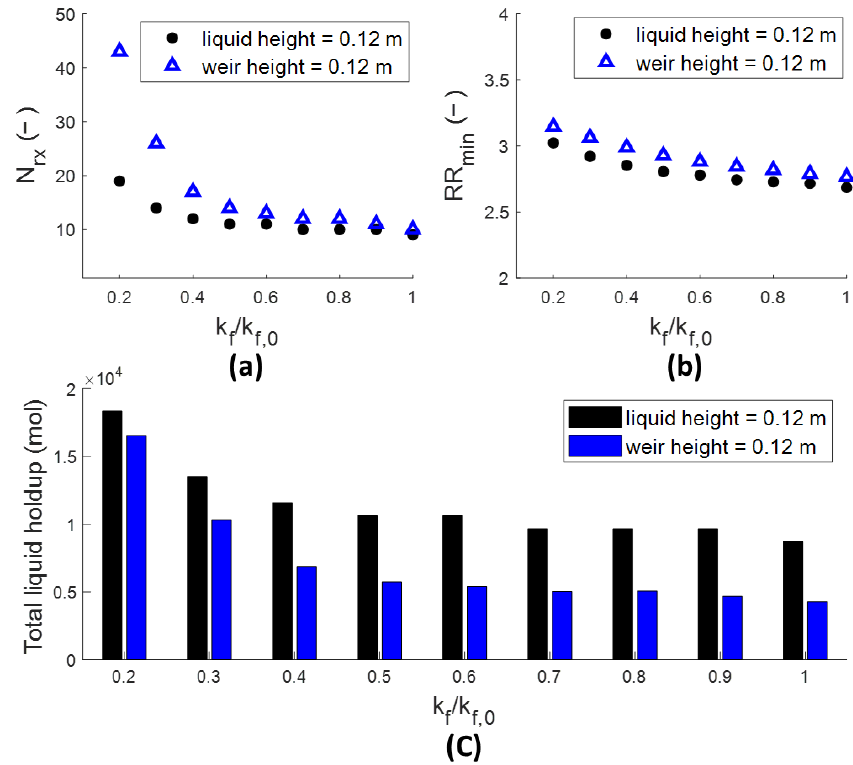
Figure 4. Number of reactive stages ( a ), minimized reflux ratio ( b ) and summed total liquid holdup over the reactive section ( c ) for both models when designing the RD column at minimized reflux. h w = 0.12 m. Kinetics correspond to 0.9–4.6 h of residence time in a CSTR to approach 95% of chemical equilibrium. Feed points are kept at the first and last reactive stages.